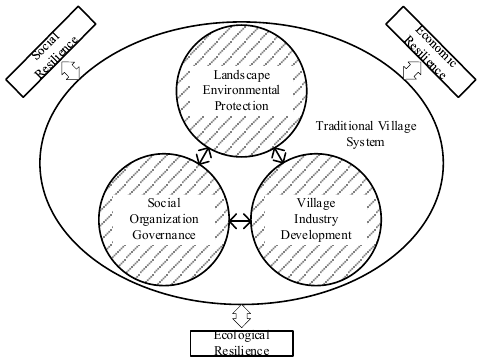
Figure 8. JSC mode diagram.